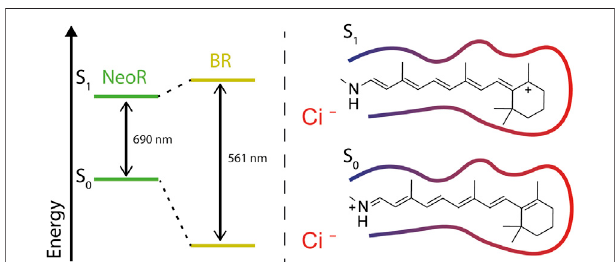
FIGURE 3 | Energy diagram of electronic ground (S0) and fi rst excited (S1)-state de fi ning the wavelengths of the absorbed light; right: charge transfer of the RSBH + in S1-positive charge locates at the β -ionone ring, where it is stabilized by polar surrounding (red contour-line). Negatively charged counterions (indicated as Ci − ) stabilizing the positive charge of the RSBH + in the ground state